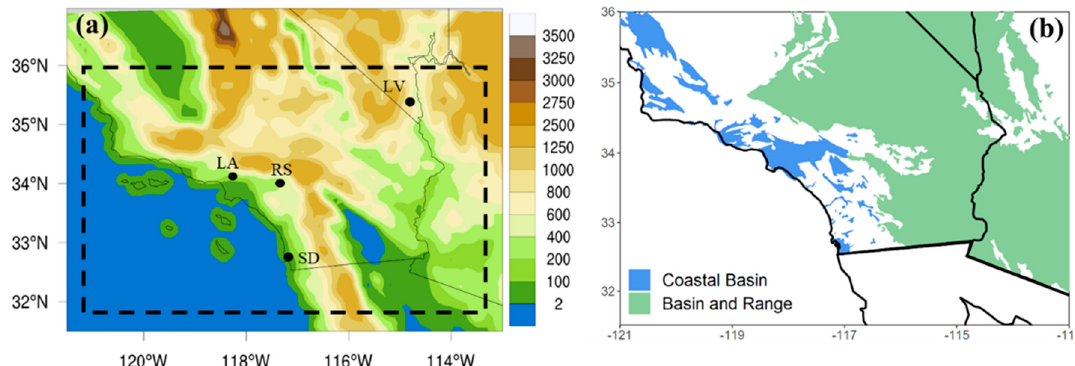
Figure 1. ( a ) Topographic map of Southern California and the domain used for the model simulations (dashed lines). ( b ) The two principal aquifer systems located within the model domain: the coastal basin aquifer system and the basin and range aquifer system. The major metropolitan areas in the domain are also shown in (a): Los Angeles, Riverside, San Diego, and Las Vegas.